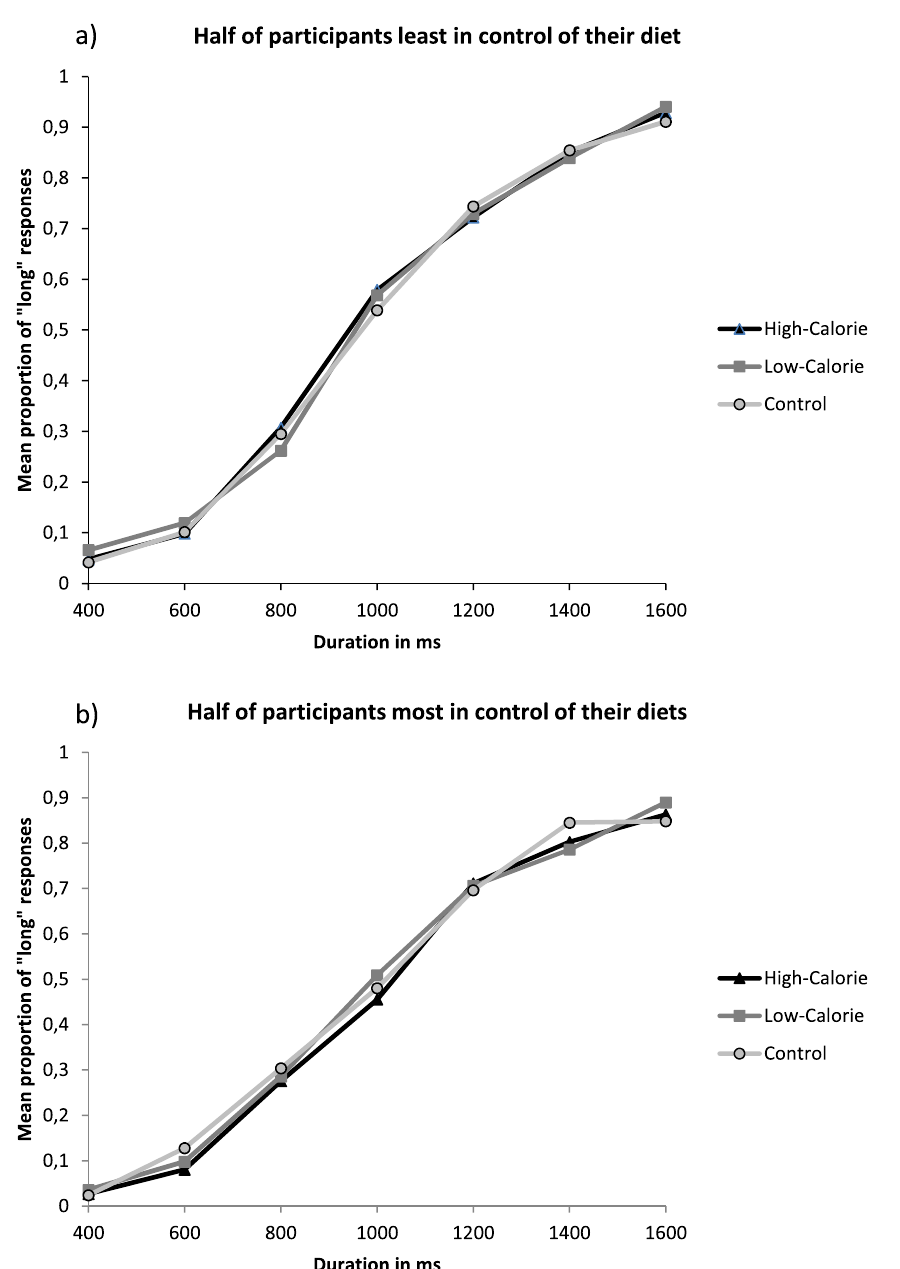
Figure 3. For graphical reasons only, this graph divides the participants according to their level of diet control. The upper panel shows the mean proportion of “long” responses plotted against stimulus duration for each picture condition associated with the half of the participants who control their diet least. The lower panel shows this same bisection task for the half of the participants who control their diet